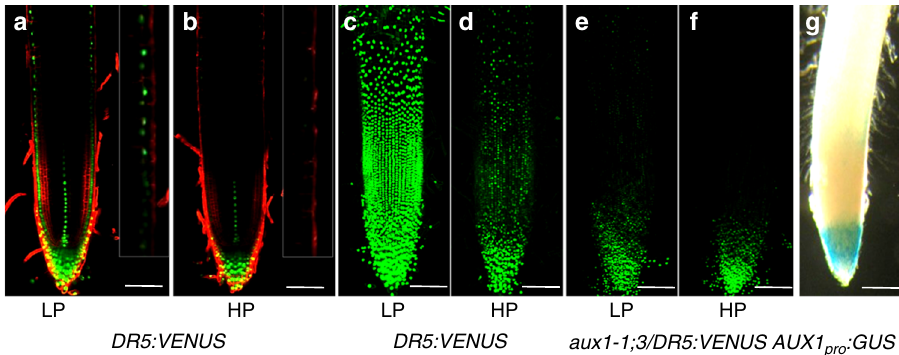
Fig. 4 Low P increases root hair zone auxin response via AUX1. a , b Two photon laser scanning microscopy images of auxin response reporter DR5:VENUS (green) fl uorescence in transgenic rice seedlings grown at either low ( a ) or high P levels ( b ). Inset shows close-up of the distal elongation zone. c – f Maximum projection confocal images of Z-stacks of DR5::VENUS fl uorescence in the roots of wild type ( c , d ) or osaux1-1;3 ( e , f ) seedlings grown in either low ( c , e ) or high P ( d , f ). g AUX1 pro :GUS lines reveal OsAUX1 root apical expression. Scale bar represents 100 µ